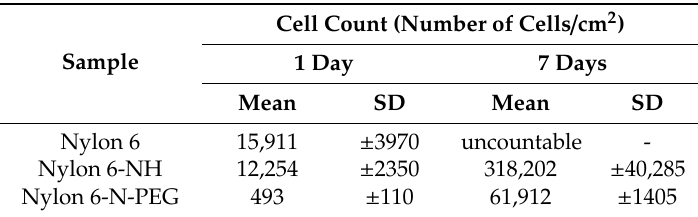
Figure 9. Fluorescence microscopy images of samples Nylon 6 ( a ); Nylon 6-NH ( b ) and Nylon 6-N-PEG ( c ), seeded with fibroblasts after 7 days of culturing. Table 3. Results of cell count after 1 day and 7 days of culturing.